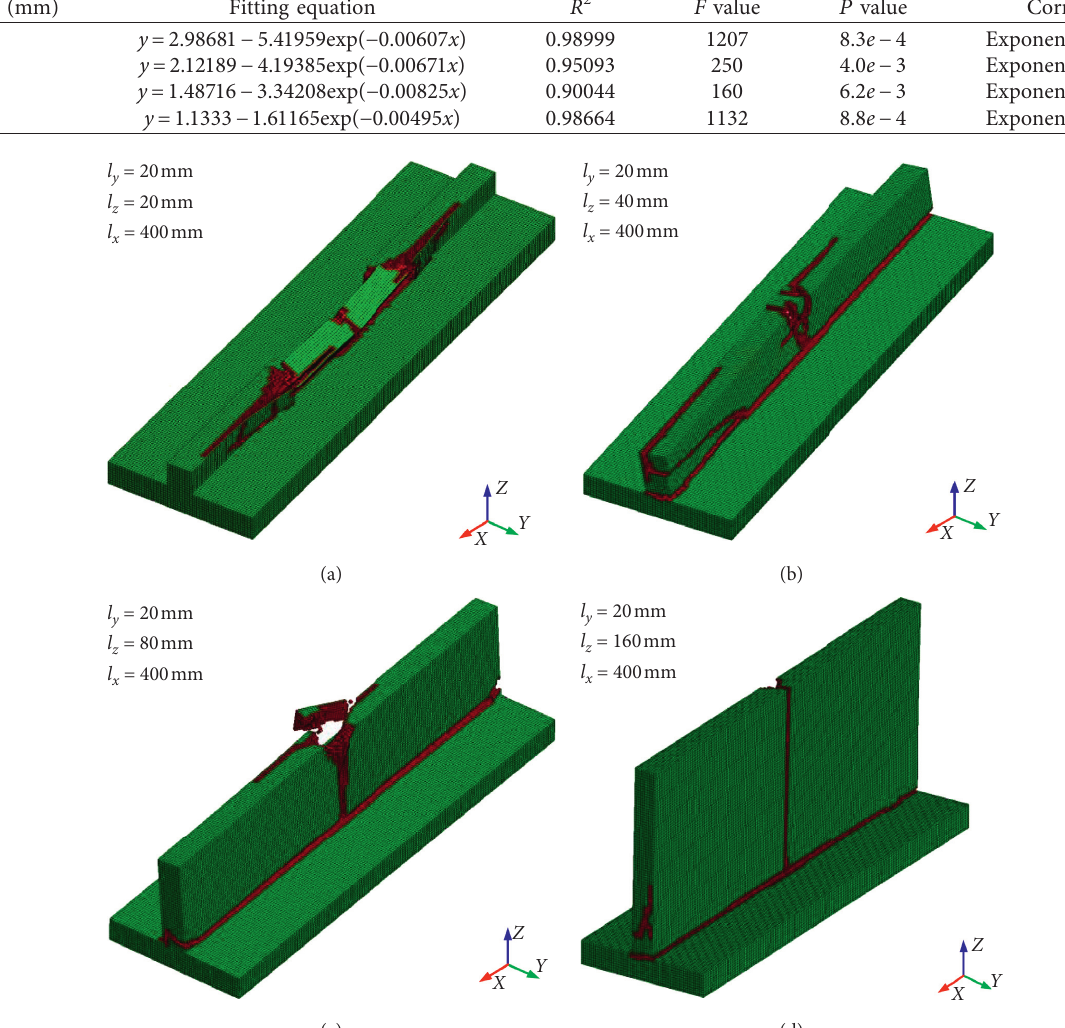
Figure 11: Results of rock plate cutting with different heights: (a) 20mm, (b) 40mm, (c) 80mm, and (d) 160